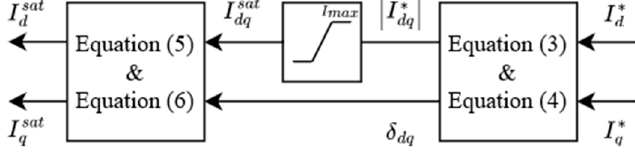
Figure 3. Implementation of vector amplitude saturation [23].